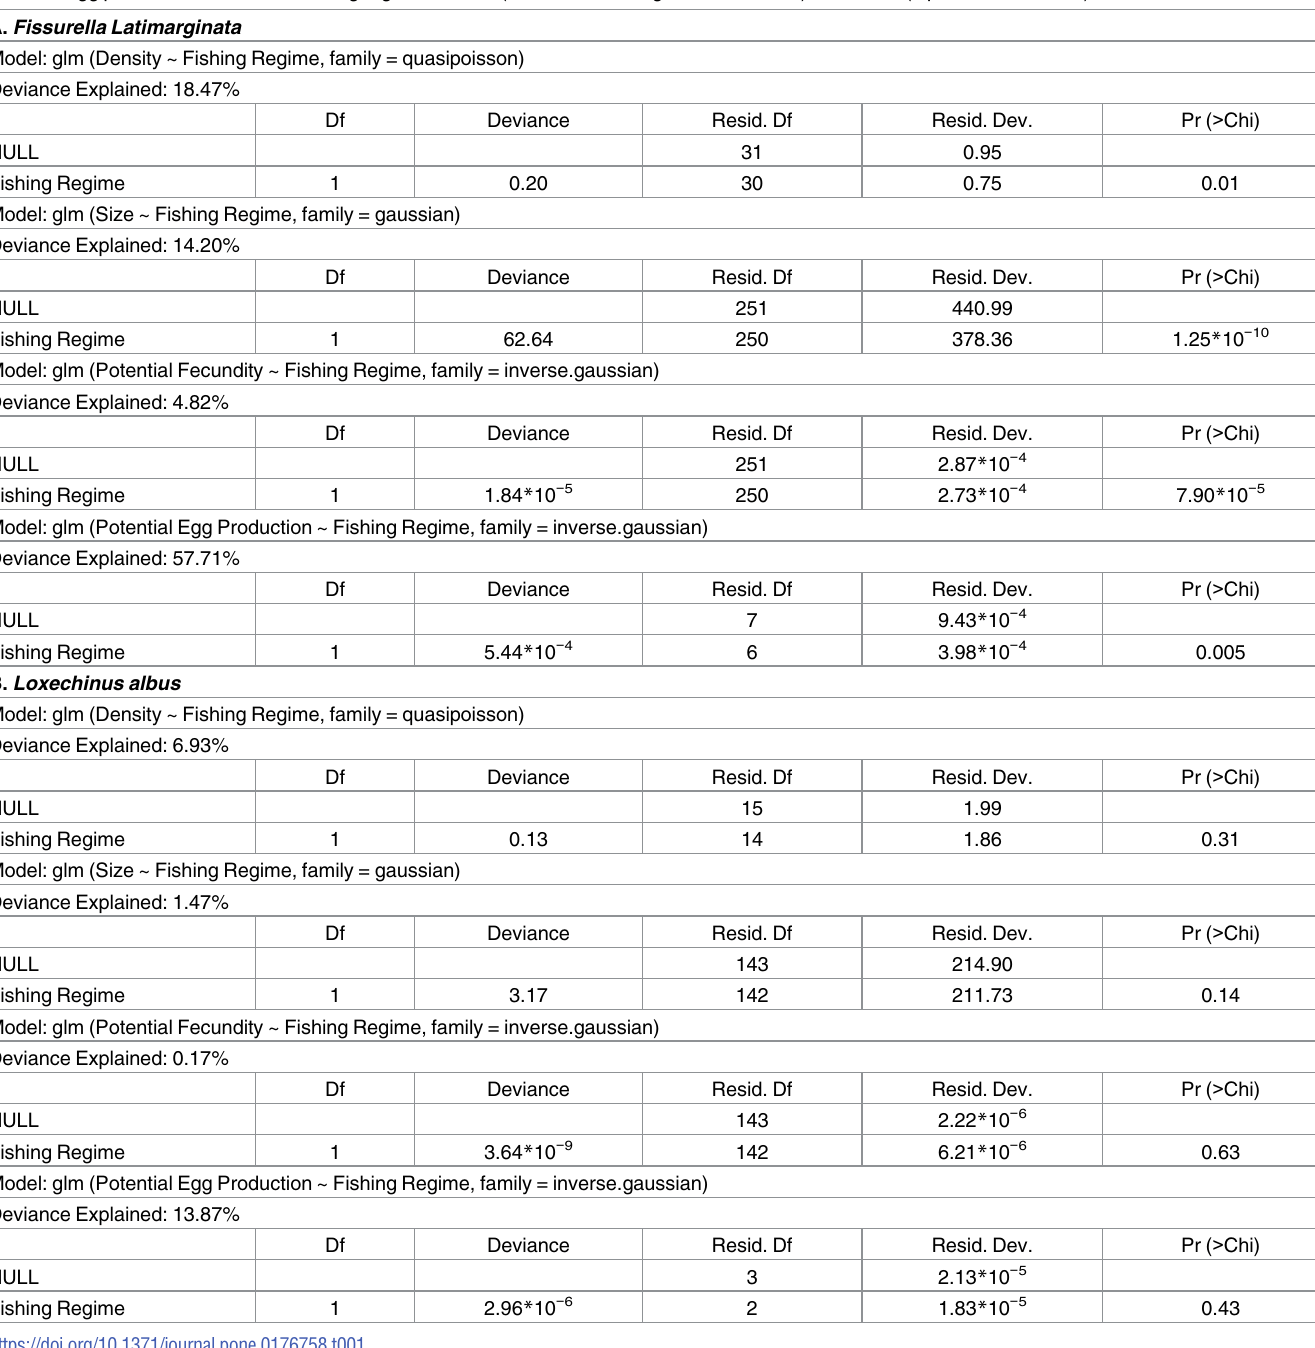
Table 1. Generalized linear models. Statistical results of the generalized linear models (GLM) appliedto density, individualsize, potentialfecundity and potentialegg production, across two fishing regime: TURFs (Territorial Use Rights for Fisheries) and OAAs (Open Access